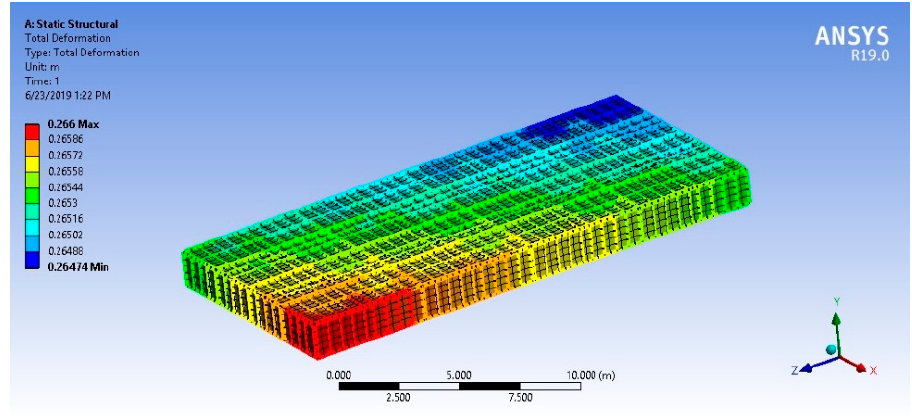
Figure 10. The numerical draft of a steel ferry under its own weight.